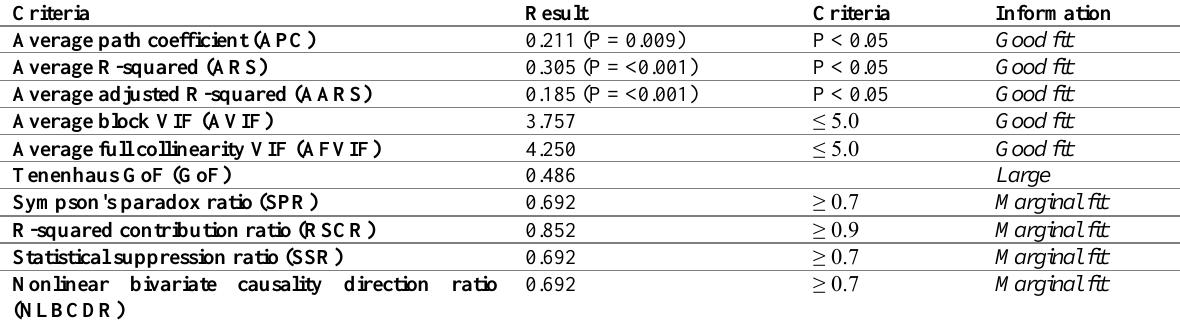
Table 7: The goodness of fit of the structural model in PLS using warpPLS